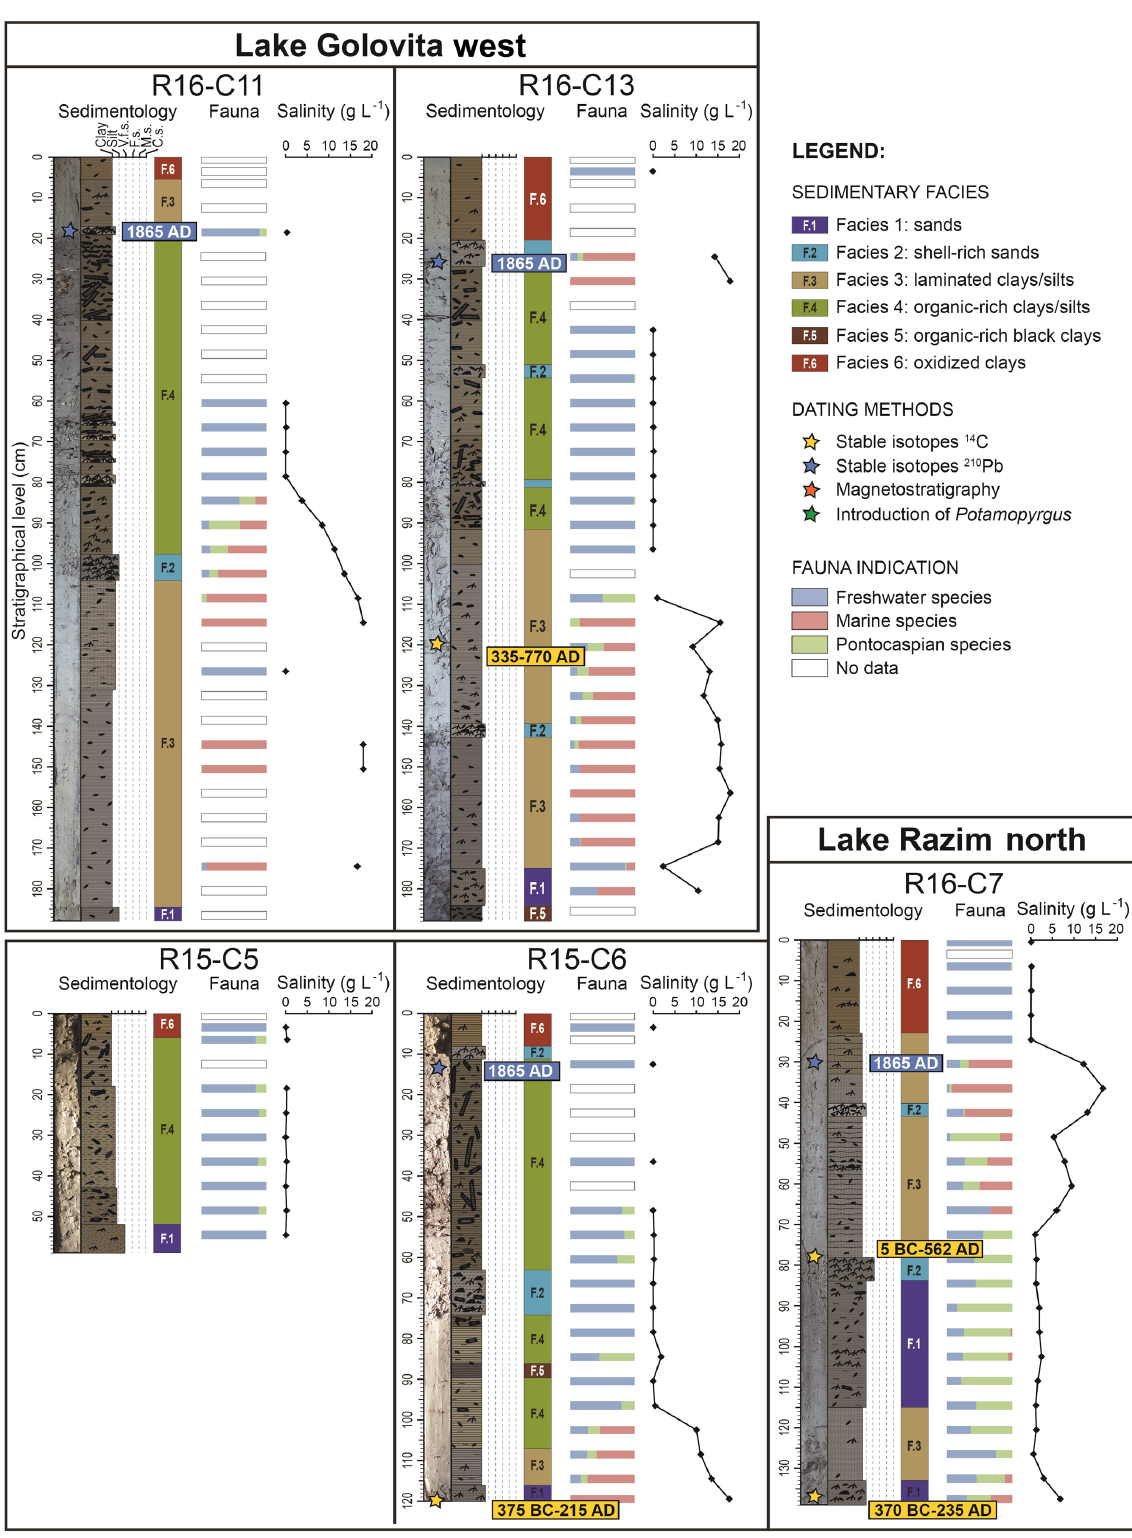
Figure 2. Overview of core data. From left to right each core: core photograph, lithology, facies, fauna relative abundance per species group based on origin, evolution and estimated